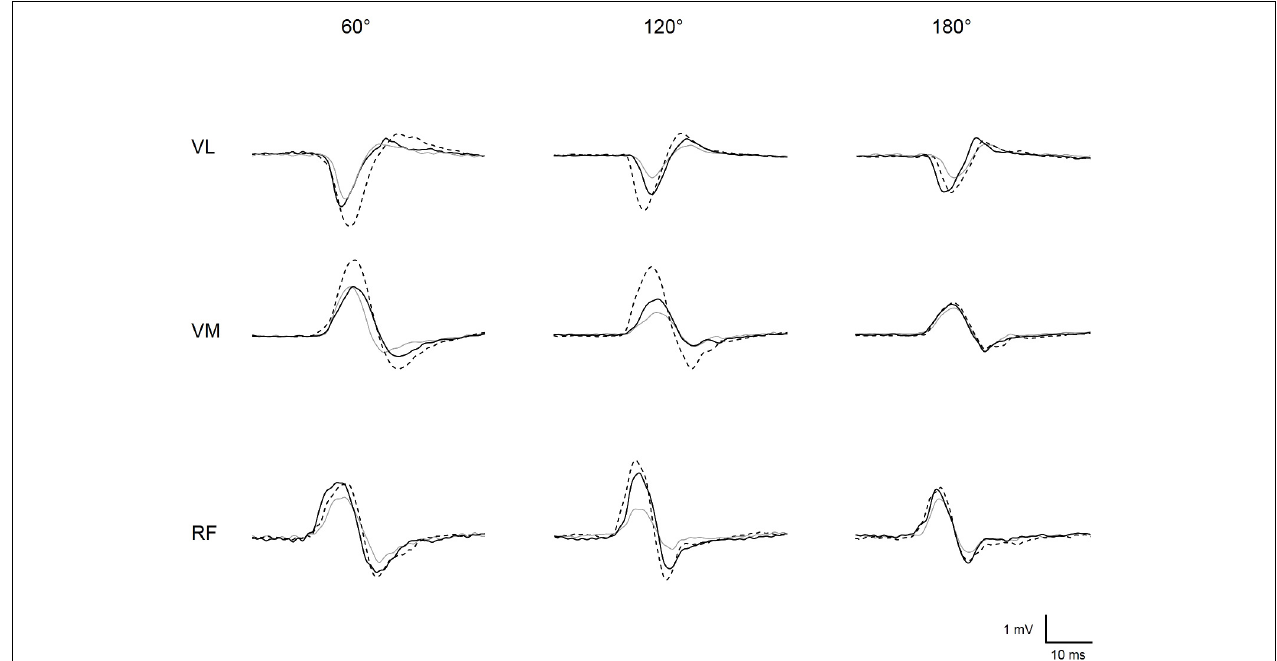
FIGURE 2 | Representative trace of MEPs recorded for vastus lateralis (VL), vastus medialis (VM), and rectus femoris (RF) at each muscle length (i.e., knee angle of 60, 120, and 180 ◦ ) when vibration was locally applied on the muscle (solid black line) or the tendon (dotted black line) or when vibration was turned off, i.e., control condition (solid gray